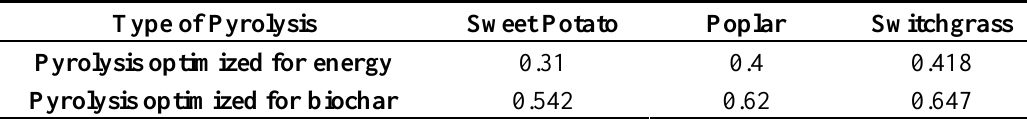
Table 3. Carbon Dioxide Offset from Burning Biooil, Biogas and Biochar (ton CO of